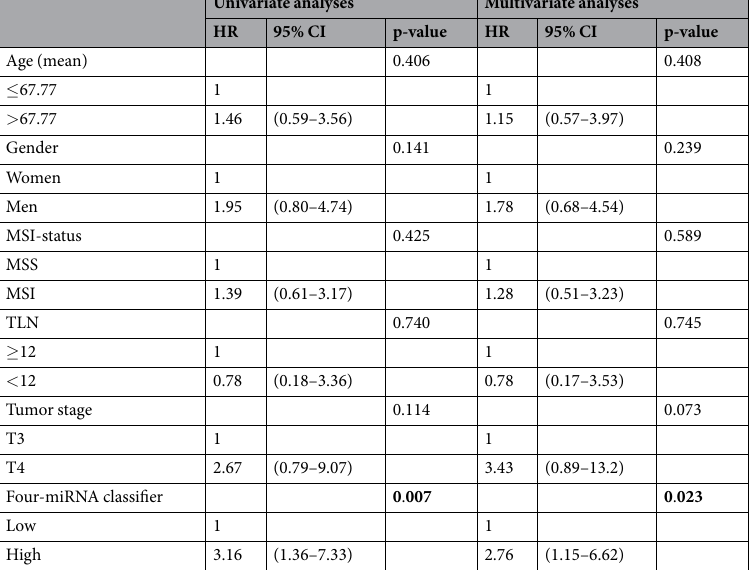
Table 2. Univariate and multivariate analyses for the four-miRNA classifier in the TCGA-COAD cohort. HR = hazard ratio, CI = Confidence interval, TLN = total lymph